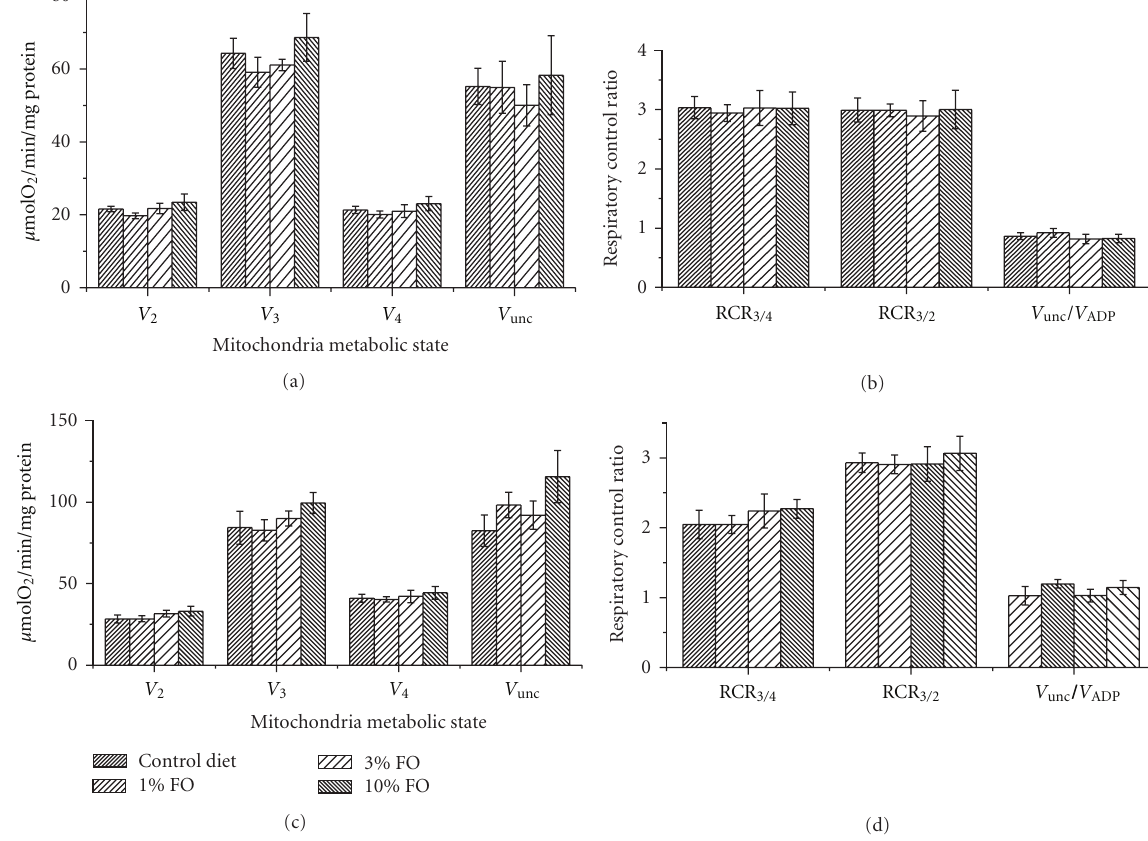
Figure 3: Omega-3 PUFA enriched diet does not a ff ect brain mitochondria respiratory parameters. (a and c) Respiration rates measured in di ff erent metabolic states state 2 ( V 2 ), state 3 ( V 3 ), state 4 ( V 4 ), FCCP-stimulated respiration ( V unc ). (b and d) RCRs. In (a and b), glutamate/malate was used to stimulate respiration initiated at complex I; in (c and d), succinate and rotenone were used to stimulate respiration initiated at complex II. The data are expressed in μ mol O 2 /min/mg protein and are the mean ± SEM, n = 6. Statistical significance in oxygen consumption between tested samples was determined by a two-sample t -test.